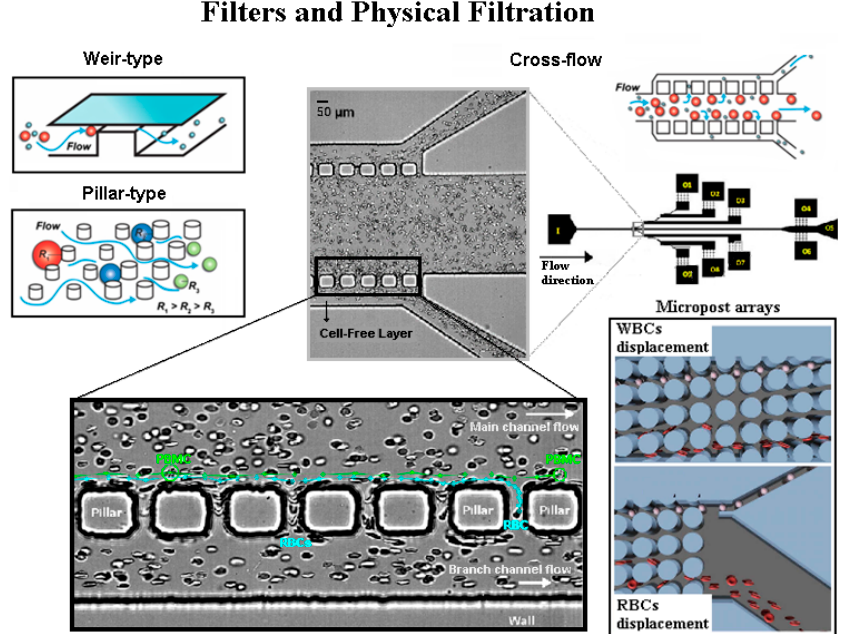
Figure 8. Schematic illustration for weir, pillar and cross-flow microfluidic filters. Images adapted from [81,84,109].